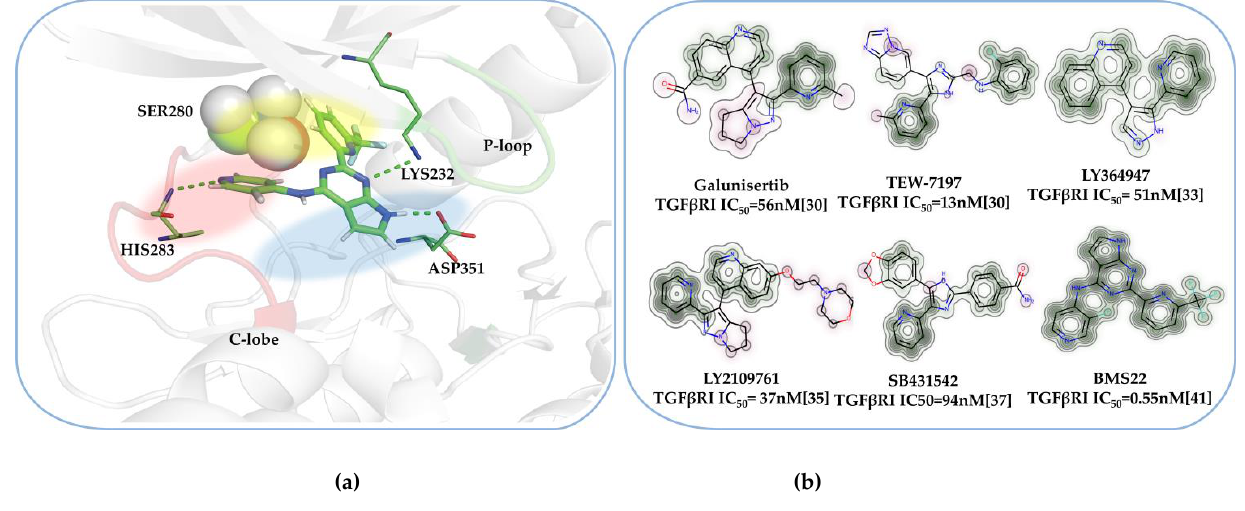
Figure 2. A: A schematic view of the binding characteristics of BMS22 in the co-crystal structural domain depicting three colored regions: the hinge region (red), the selective hydrophobic pocket (yellow), and the solvent channel area (blue). As a type Ⅰ kinase inhibitor, BMS22 accommodates the DGF- in state of TGFβR Ⅰ . B: The similarity map of clinical trials testing TGFβR Ⅰ inhibitors and BMS22 was predicted by Rdkit (http://rd.sourcceforge.net) based on MorganFingerprint, and the latter was the reference drug in this study (the greener the atom, the greater the similarity contribution). The source of the data literature is indicated in parentheses in Figure 2B.